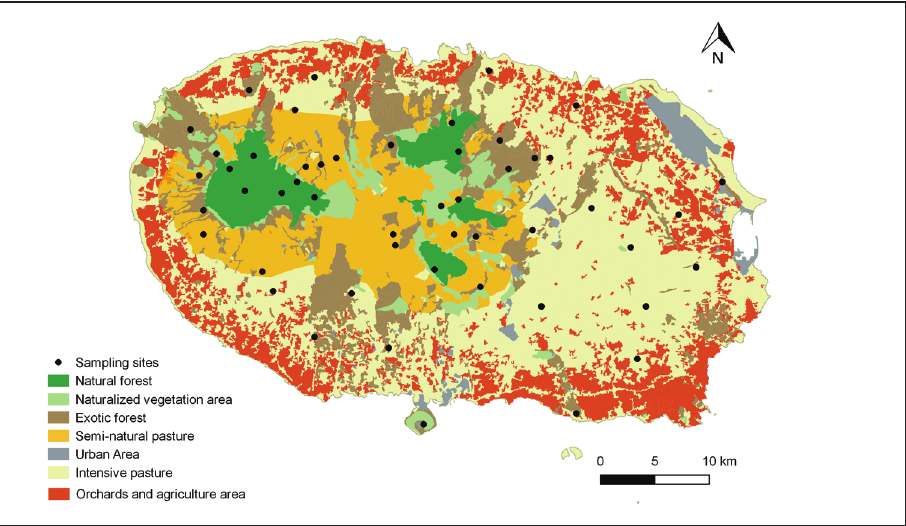
Figure 1. Land use distribution map of Terceira Island with the selected sampling sites as black dots: NatFor (natural forests), SemiPast (semi-natural pastures), NatVeg (naturalized vegetation areas), ExoFor (exotic forests), IntPast (intensively managed pastures), urban areas and agriculture areas. Land use carto- graphic sources: DROTRH (2008) and Gaspar (2007).